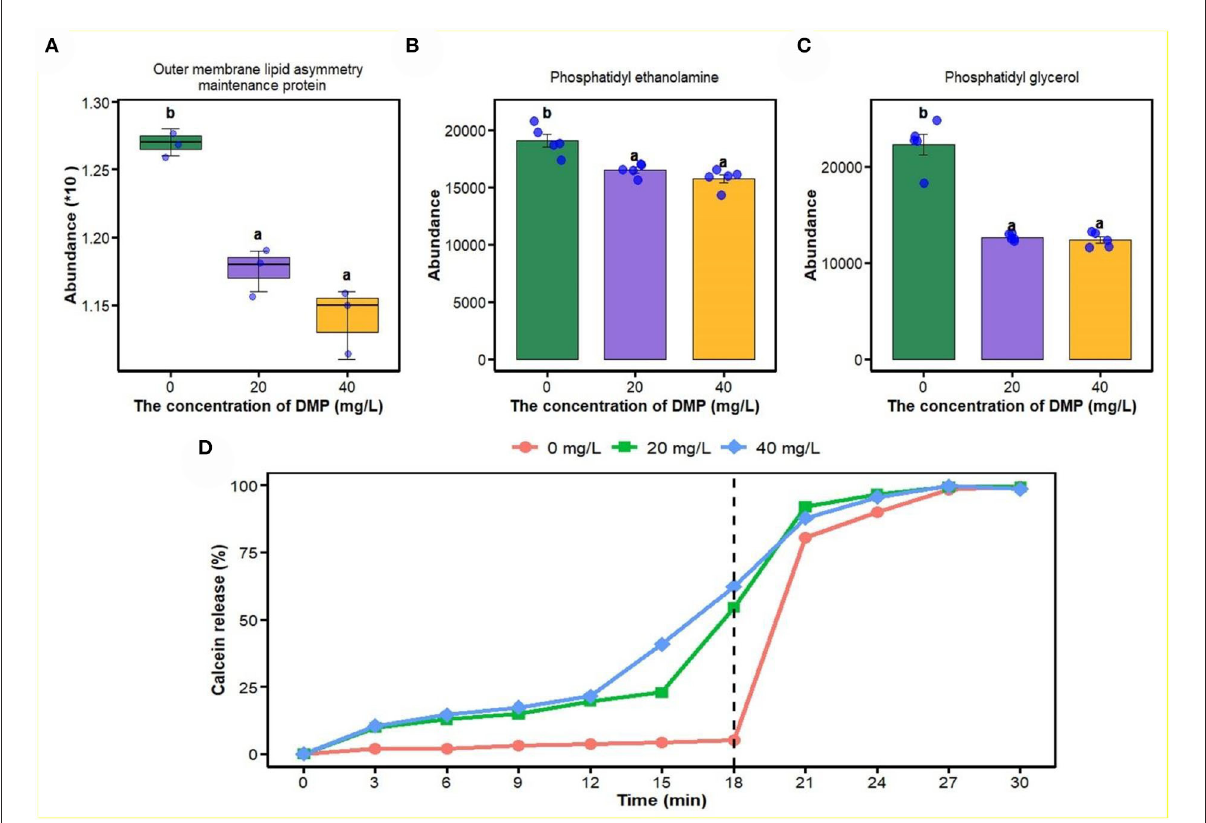
FIGURE3 The effect of DMP on the phospholipid and integrity of cell membrane of the P. fluorescens . (A) indicates that DMP inhibited the expression of outer membrane (OM) lipid asymmetry maintenance protein abundance through proteomics; (B , C) indicate that the abundance of phosphatidyl ethanolamine (PE) and phosphatidyl glycerol (PG) were decreased by DMP treatment through metabolomics; (D) indicates that the integrity of the cell membrane of P. fluorescens was changed by DMP treatment by the calcein release test. Different letters represent significant differences between